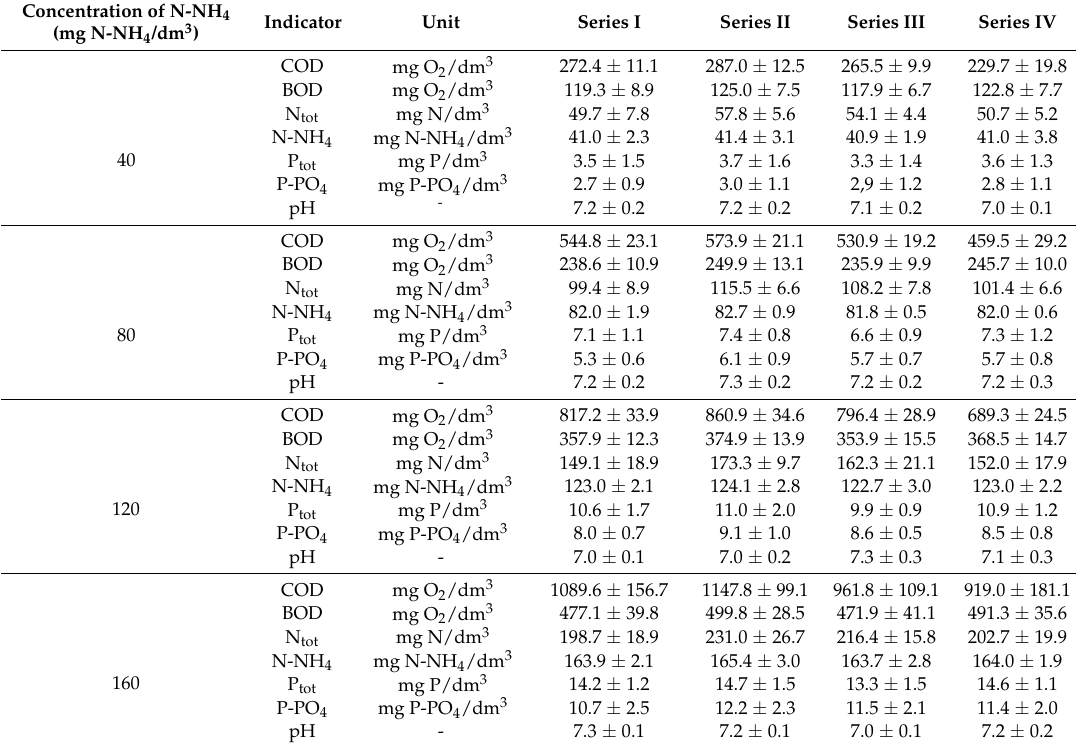
Table 3. The initial concentrations of indicators in the medium depending on variant and series of the experiment.